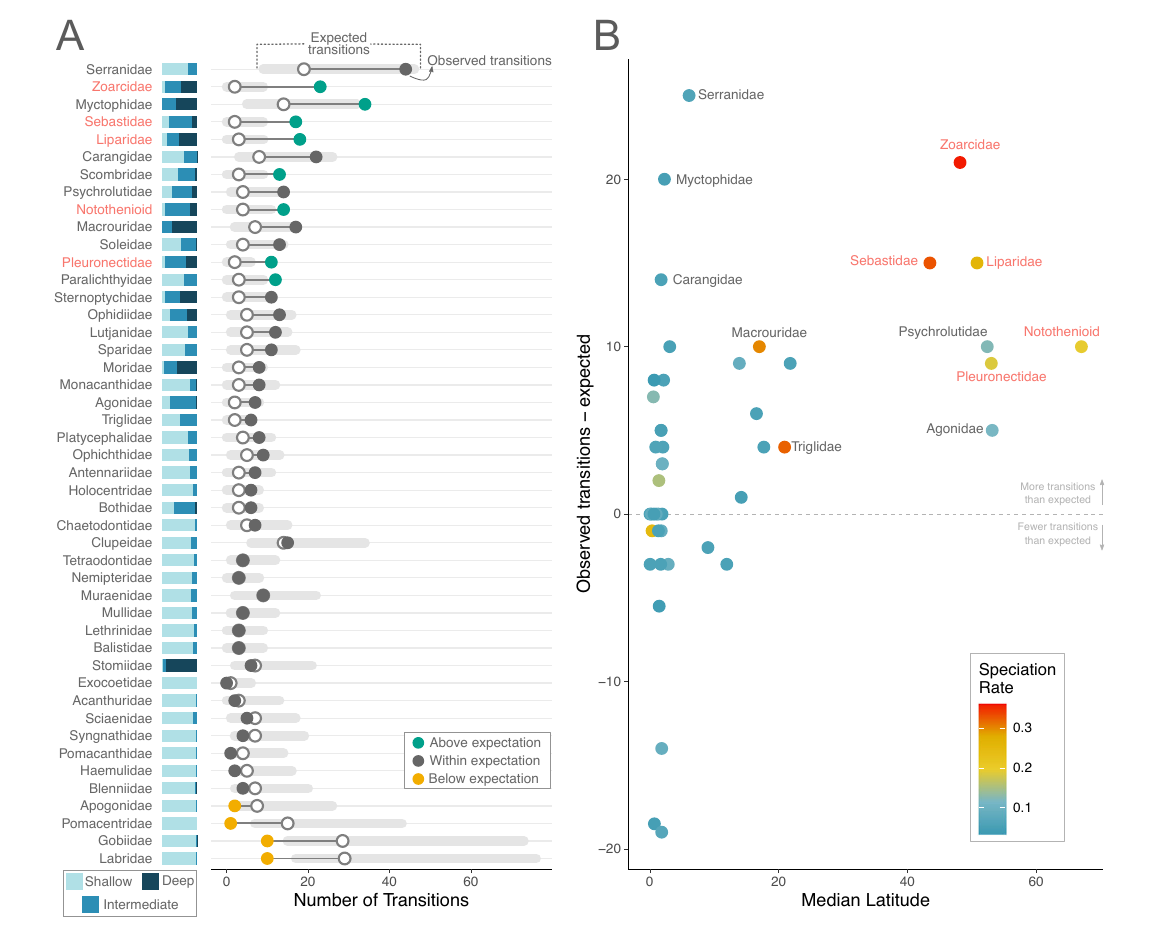
Fig. 1 | Clade-speci fi c lability along the depth gradient increases with latitude. Thefarleft( A )showsdepthcompositionofextantspeciesineachfamily.Namesin redarethefocalhigh-latitude,rapidlyspeciatingclades.Foreachclade,thenumber oftransitionsbetweendepthcategoriesiscomparedtoanulldistributionofdepth transitions within that clade (gray region). Open points represent the median null expectation, whereas closed points represent the observed number of depth